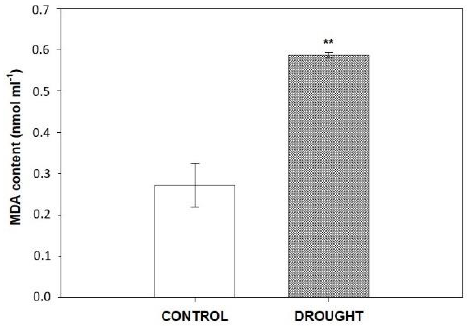
Figure 1. Effect of soil drought on the malondialdehyde (MDA) level in the flower abscission zone (AZ) of Lupinus luteus . Flower AZ was excised from plants subjected to 2 weeks of drought (25% water holding capacity, WHC) or lupines growing under optimal moisture (70% WHC, control). Results are presented as means ± SE ( n = 3). Asterisks indicate a significant difference (Student ’ s t-test: ** p < 0.01).